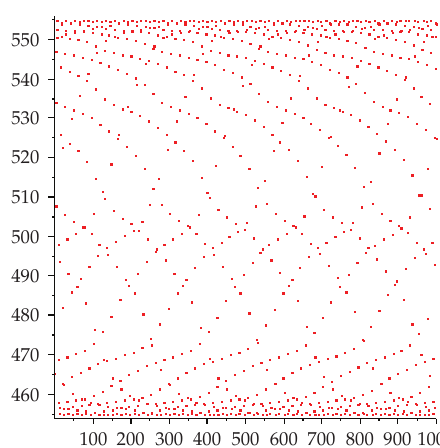
Figure 1: (cid:2) t,y (cid:2) t (cid:3)(cid:3) in the deterministic case for d (cid:7)